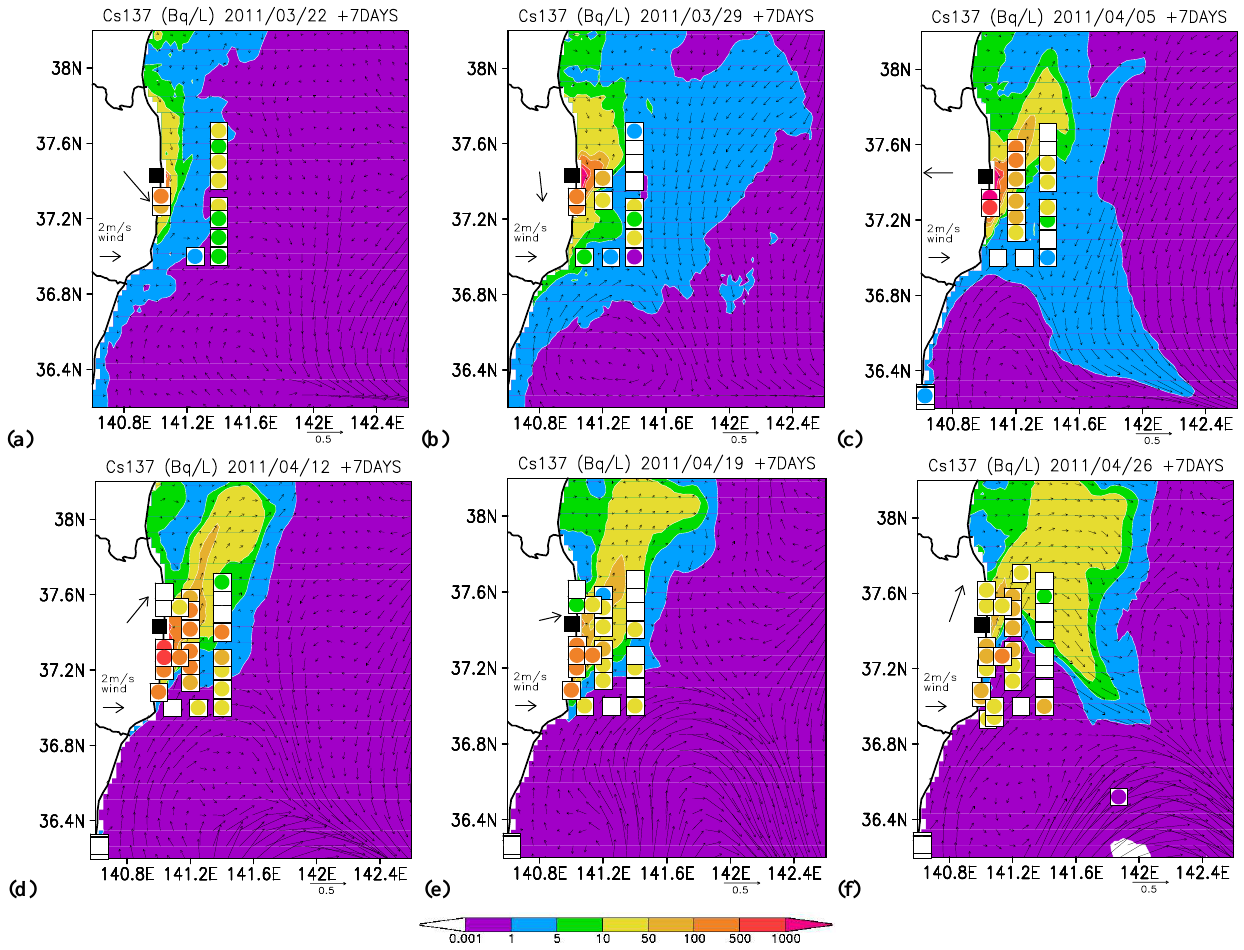
Fig. 7. As in Fig. 5, except for the JCOPE-T-2-C-E case.